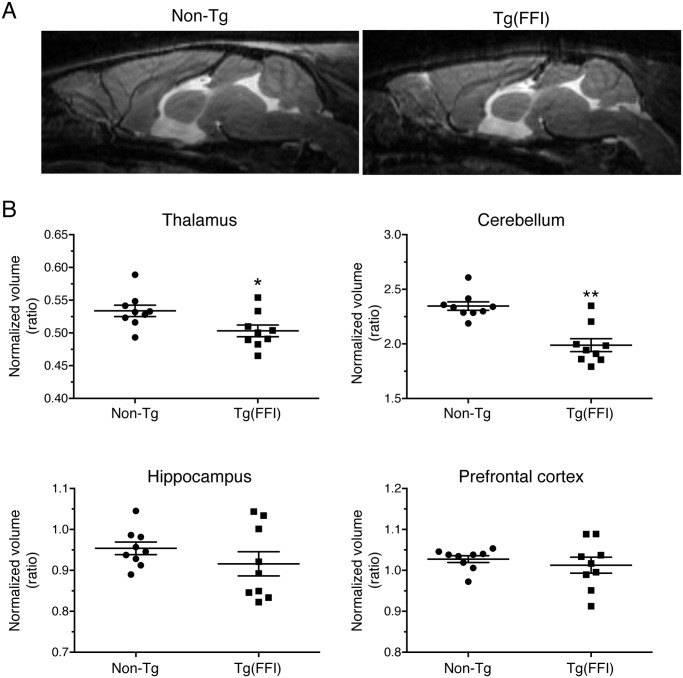
Tg(FFI) mice show thalamic and cerebellar atrophy.(A) Brain anatomy of a non-Tg/Prnp
0/0 and a Tg(FFI-26+/-)/Prnp
0/0 mouse aged 460 days. Representative T2-weighted images (TE/TR = 50/2500 ms). (B) Volumes of individual brains areas of 9 Tg(FFI-26+/-)/Prnp
0/0 and 9 non-Tg/Prnp
0/0 littermates aged between 408 and 498 days were quantified as described in the Experimental Procedures. To reduce interindividual variation, volumes were normalized on the values of the striatum which were the same in non-Tg and Tg(FFI) mice (non-Tg: 20.83 ± 0.30 mm3, Tg(FFI): 20.09 ± 0.32 mm3; mean ± SEM, p = 0.22 by Mann Whitney test). *p < 0.05 and **p < 0.01 vs. non-Tg by Mann Whitney test.